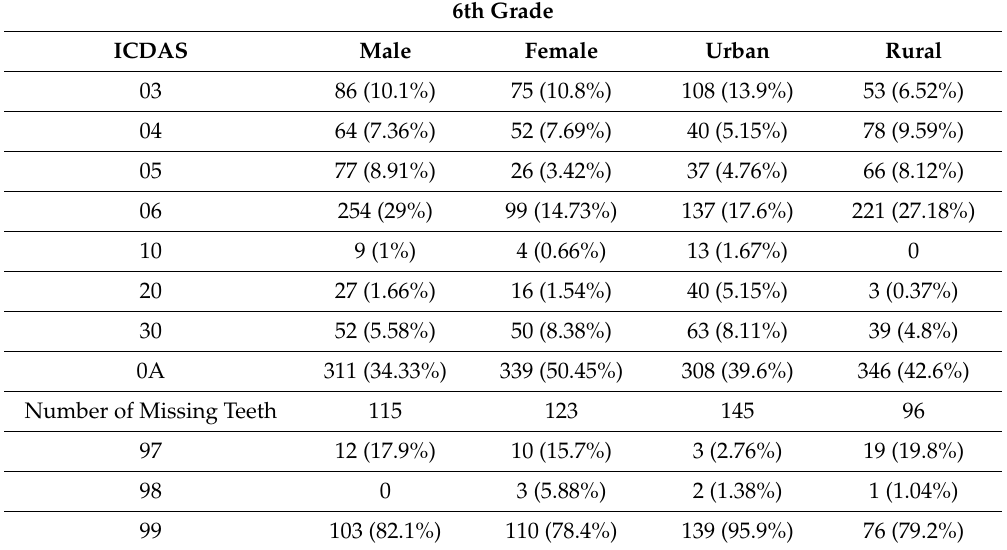
Table 3. Most frequent ICDAS scores for the 12-year-old group (percentage of total cases for male and female respectively, percentages calculated to the total numbers of cases for each